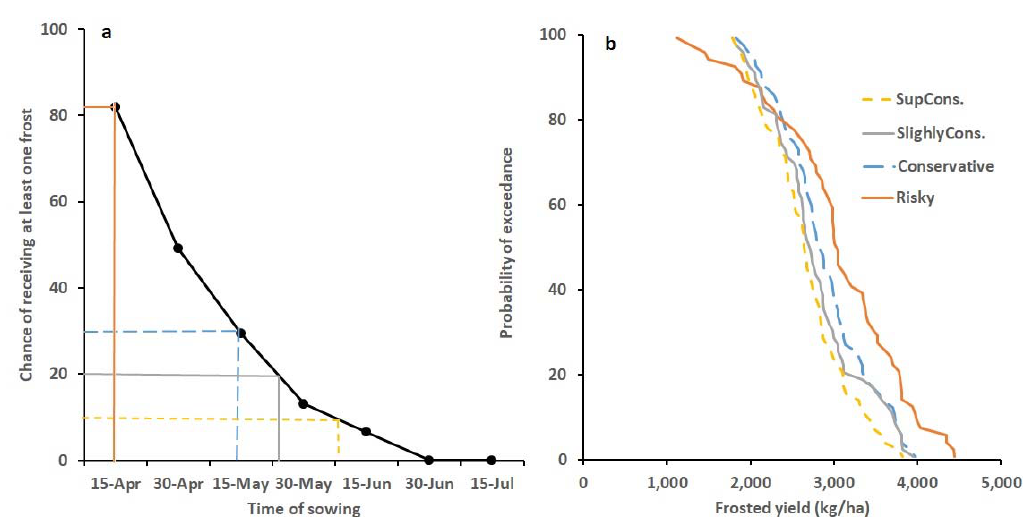
Figure 6. Risk of receiving at least one frost during the reproductive stage in di ff erent sowings at Dalby on the Darling Downs in Queensland ( a ) and the consequence on yield from the adoption of sowings date based on 10% frost risk (super conservative), 20% frost risk (slightly conservative), 30% frost risk (conservative), and no consideration of frost risk (risky) ( b ). The probability of exceedance on the y-axis is a statistical metric describing the probability that a particular value on x-axis will be met or exceeded.